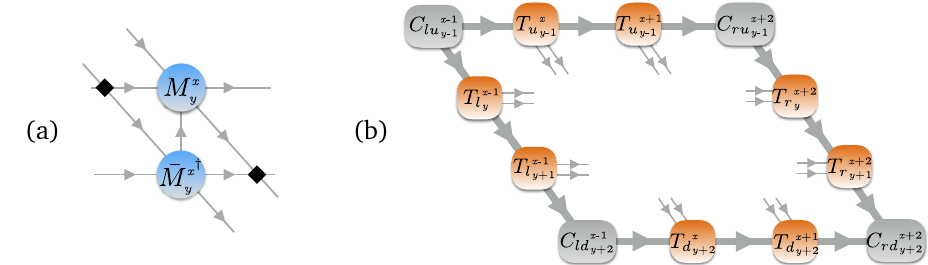
Figure 6: Arrow convention for M tensor (panel a) as they enter inside the corner transfer matrix (CTM) setup in (panel b). The latter combines bra and ket state as required for the minimization of the total energy E = 〈 ψ | H | ψ 〉 when truncating [ 58 ] . From the perspective of an individual site, this “double layer” tensor network trans- lates into 〈 M | ... | M 〉 . For this, note that we have reverted the bond indices of the ‘bra-tensor’ M → ¯ M such that they point in the same direction as the corresponding indices of M . Only then one can fuse the ‘double bond index’ into a single fat in- dex. This greatly simplifies many fusion steps during the CTM procedure. The black diamonds in (a) indicate fermionic swap gates [ 45,85 ]